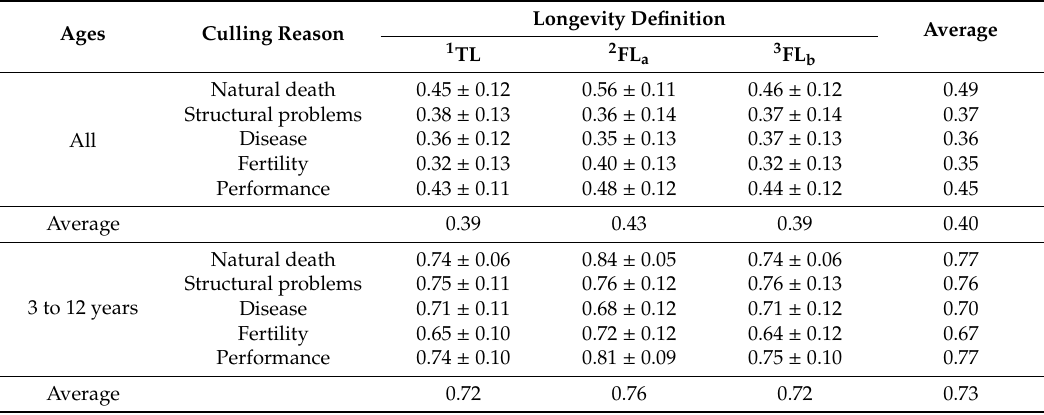
Table 4. Average ( ± SE) genetic correlations estimated considering all ages (i.e., from 2 to 15 years) and ages between 3 and 12 years-old for all longevity definitions and known culling